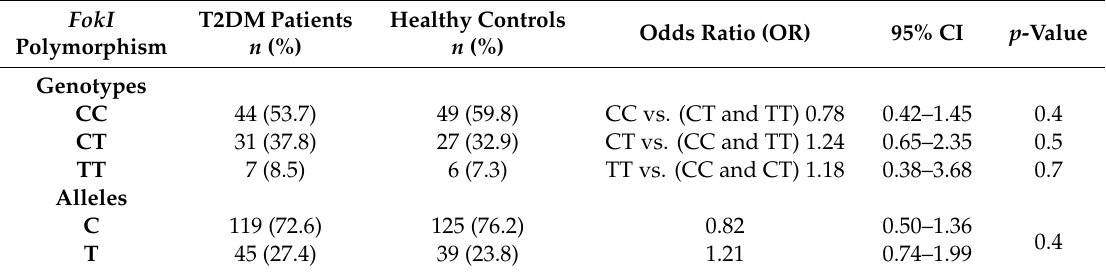
Table 4. Analysis of patients ( n = 82) vs. controls ( n = 82) FokI polymorphism genotypes and alleles frequencies for T2DM patients and healthy controls.